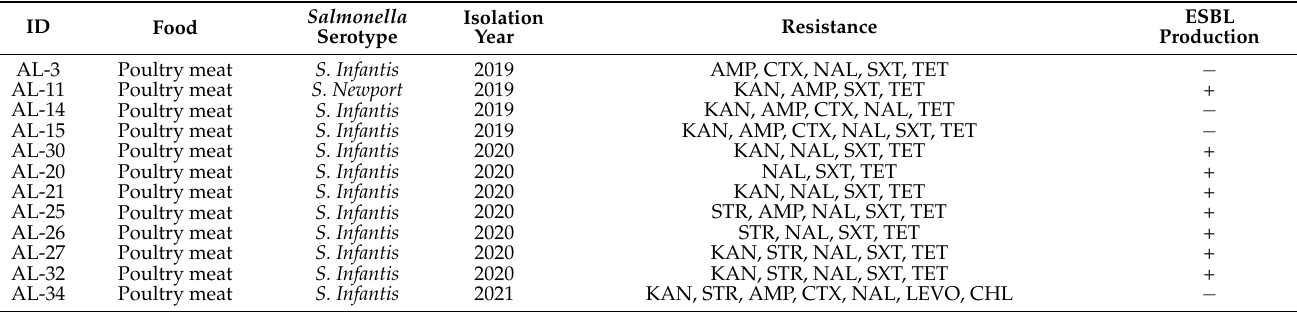
Table 2. Resistance and ESBL production test results of the 36 MDR Salmonella